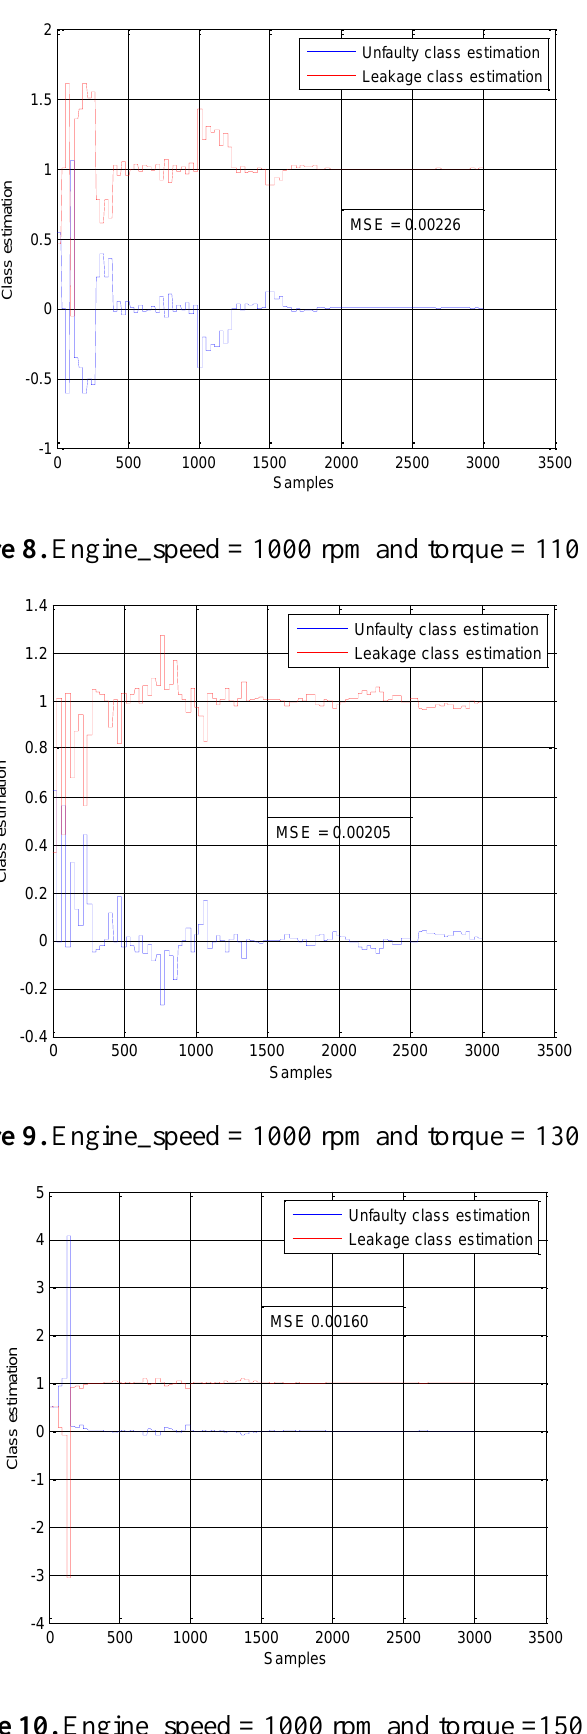
Figure 10. Engine_speed = 1000 rpm and torque =150